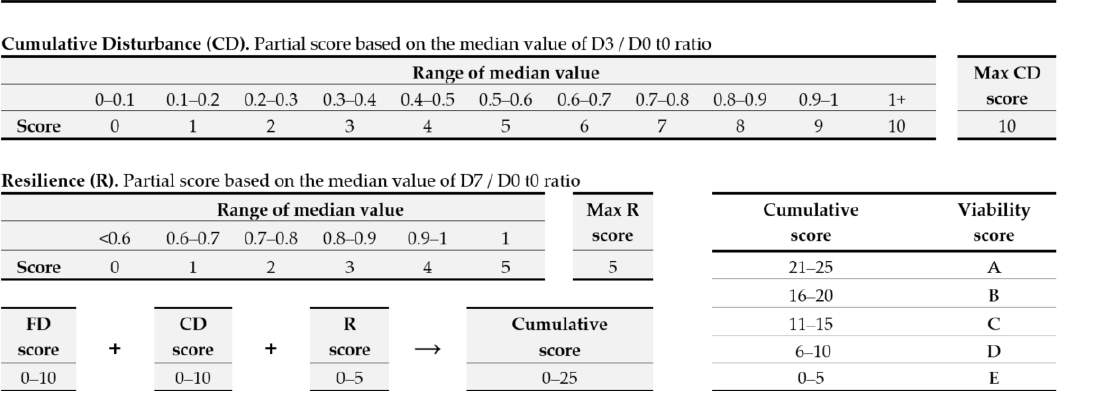
Figure 5. Parameters used to quantitatively assess how topical application of an ingredient affects skin bacterial density, and assignment of a viability score.